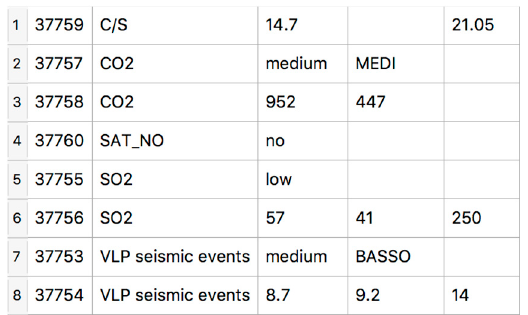
Figure 5. Validation of automatic tagging per typology (the six columns list: row number, unique ID, parameter name, and the values found in the LGS daily, LGS weekly and INGV weekly bulletins).